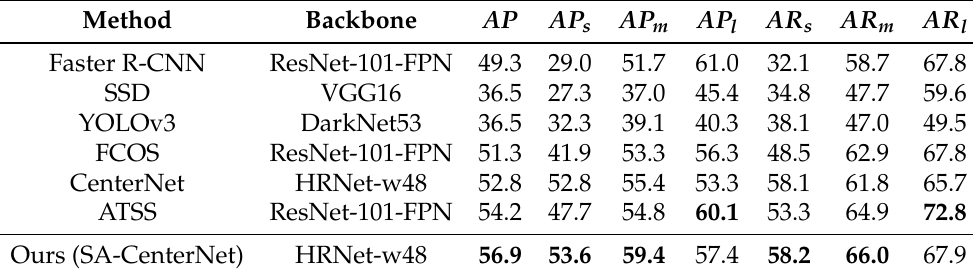
Table 1. Experimental results from different models on the KITTI dataset. All competing algorithms are implemented with MMDetection, and the default settings are used for the